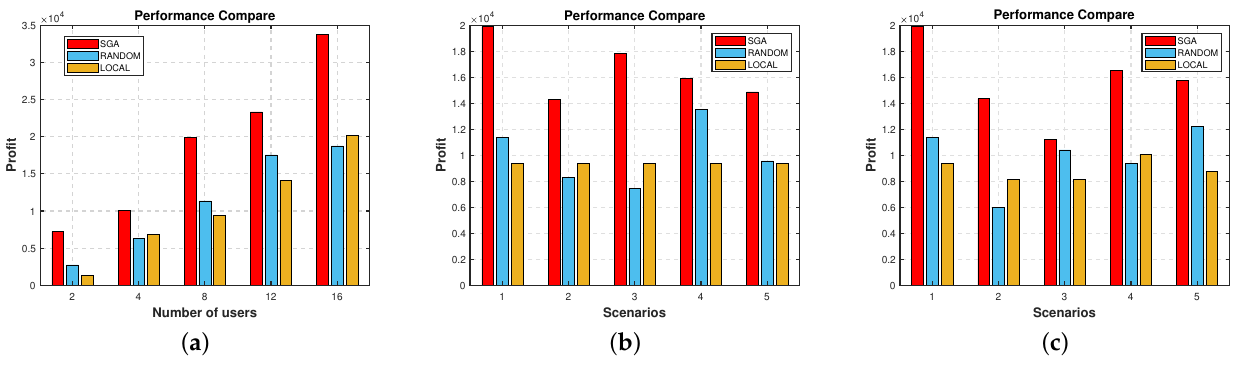
Figure 6. Performance comparison in different scenarios. ( a ) Different number of users. ( b ) Different user locations. ( c ) Different amount of